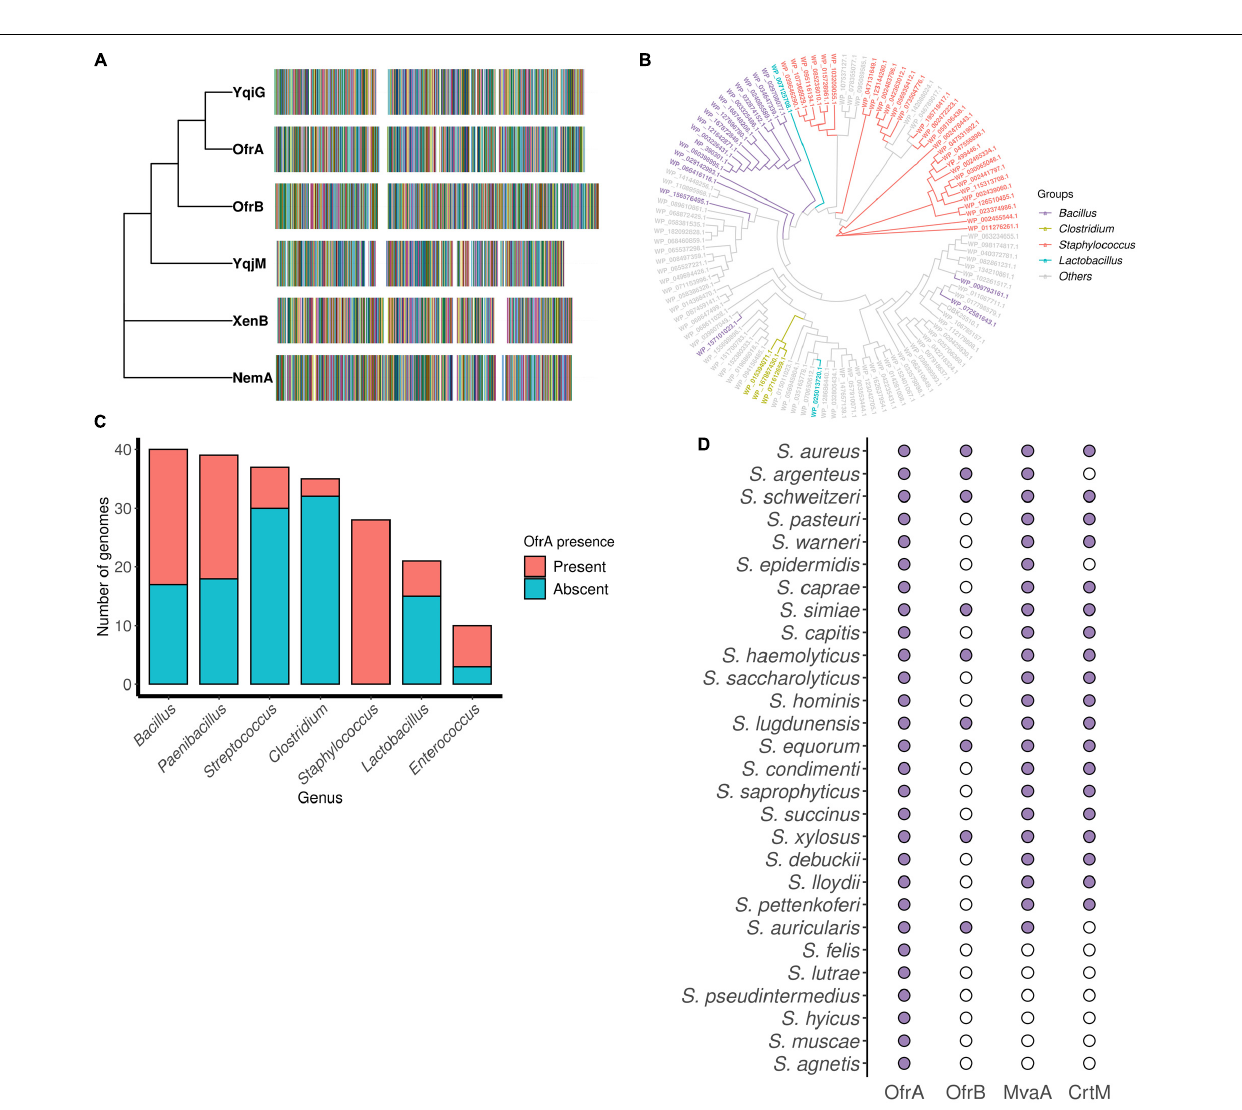
FIGURE 1 | OfrA conservation in Firmicutes and staphylococci. (A) Phylogenetic analysis of OYE examples in Gram-positive S. aureus (OfrA, OfrB) and B. subtilis (YqiG, YqjM) compared to the Gram-negative E. coli (NemA) and Pseudomonas fluorescens (XenB) with distinctive multiple sequence alignment generated by Clustal Omega. (B) Maximum likelihood tree showing the evolutionary relationship of OfrA in different Firmicutes chromosomes. Multiple sequence alignment was utilized to build the phylogenetic tree using RAxML software and visualized with ggtree. (C) Bar chart shows the presence or absence of OfrA in seven Firmicutes genera ( Bacillus , Paenibacillus , Streptococcus , Clostridium , Staphylococcus , Lactobacillus , and Enterococcus ). Filtration criteria were based on 35% amino acid identity cutoff and protein length = 375 ± 38 amino acids, refer to section “Materials and Methods”. (D) OfrA conservation across the different staphylococci compared to the conservation of OfrB, MvaA (mevalonate pathway), and CrtM (staphyloxanthin biosynthesis) in the same genomes. Filled and unfilled circles indicate gene presence and absence, respectively. CrtM, squalene desaturase; MvaA, hydroxymethylglutaryl-CoA reductase; OfrA, o ld yellow enzyme f lavin oxido r eductase A ; OfrB, o ld yellow enzyme f lavin oxido r eductase B